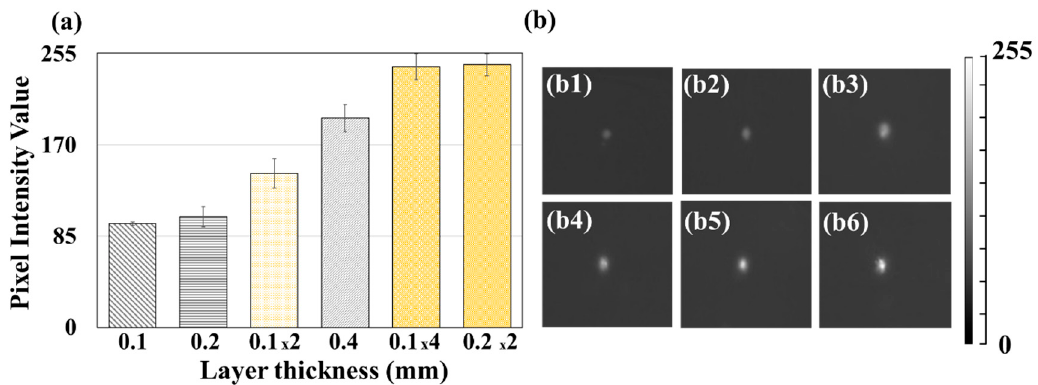
Figure 5. Pixel intensity value (PIV) of ML/PVDF composites with different thickness and layers. ( a ) The maximum PIV of ML/PVDF composites; ( b1–b6 ) instant capture of ML/PVDF composites of a single layer of 0.1 mm fabric ( b1 ), 0.2 mm ( b2 ), 2 layers of 0.1 mm thickness ( b3 ), a single layer of 0.4 mm ( b4 ), 4 layers of 0.1 mm fabric ( b5 ), and 2 layers of 0.2 mm fabric ( b6